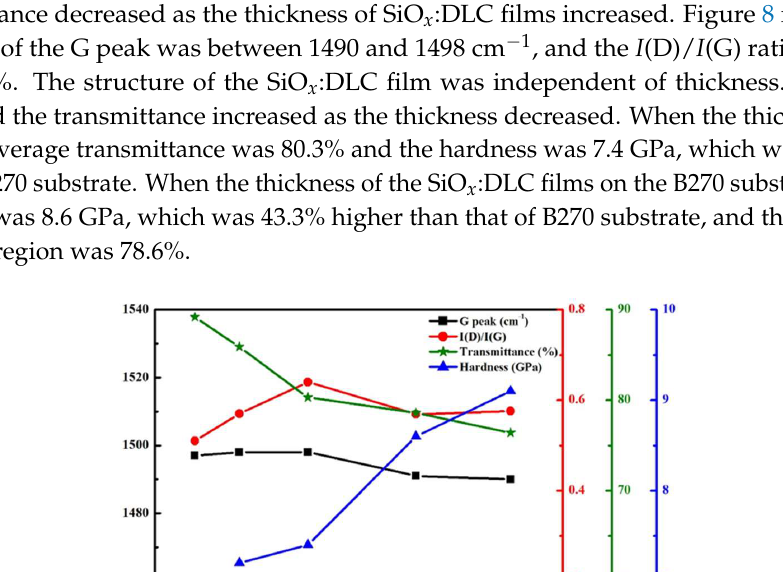
Figure 7. The X-ray photoelectron spectroscopy (XPS) relative atomic content of C, Si, and O at the different HMDSO flow rates. (RF bias = 400 V, DC power = 50 W, CH 4 = 12.5 sccm, thickness = 65 ± 5 nm). The thickness of the SiO x :DLC films was controlled from 9.8 to 87.2 nm. Figures 8 and 9 display